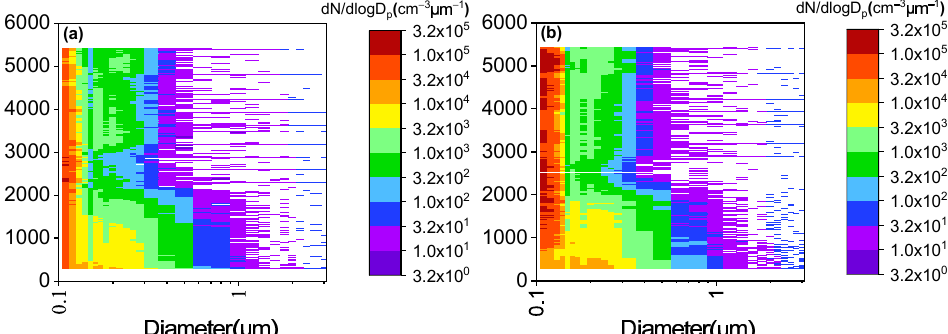
Figure 7. Vertical variation of the average aerosol size distribution during the ascent stage ( a ) and during the descent stage ( b